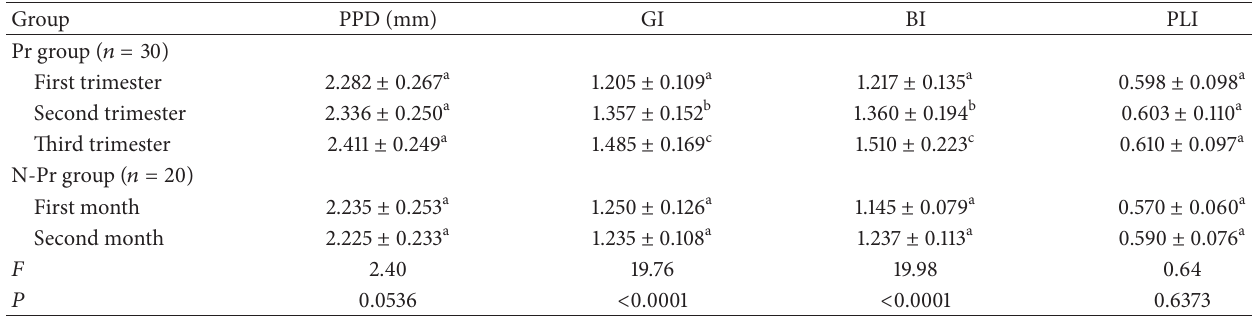
Table 3: Periodontal parameters in pregnant group and nonpregnant group ( 𝑥 ± 𝑠 ).